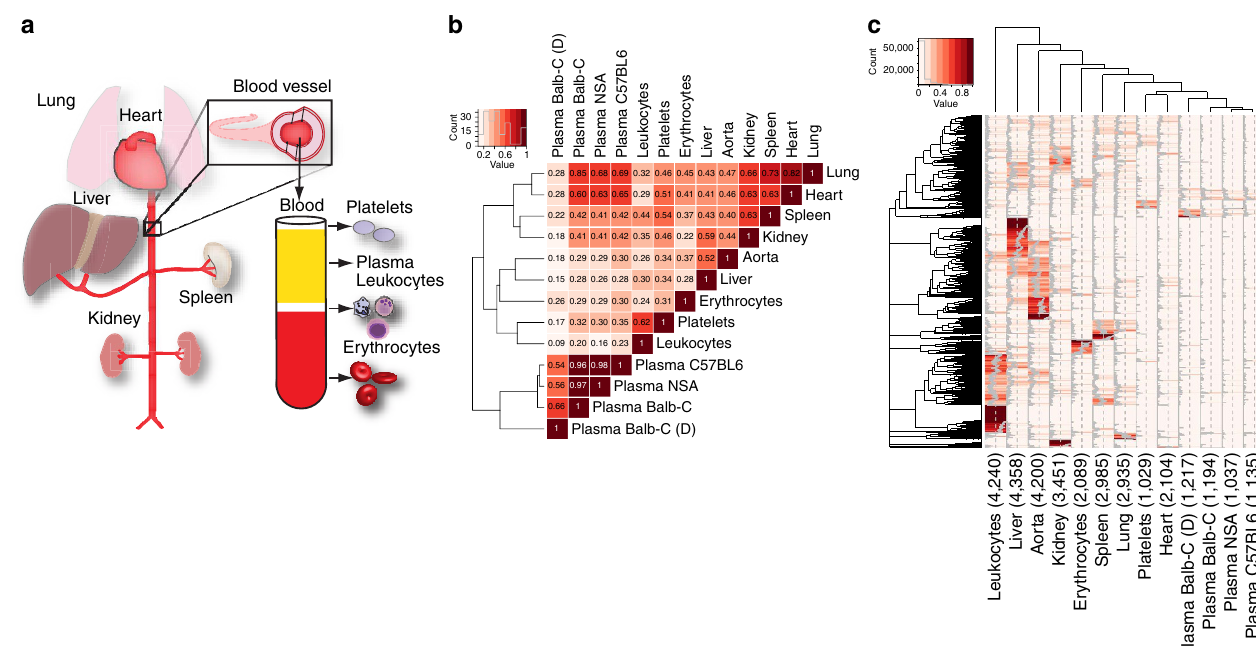
Figure 1 | Construction of a tissue-specific protein abundance atlas. ( a ) Vascularized organs, plasma and cells adjacent to the blood plasma were collected from healthy Balb-C mice. The collected organs and cells were washed in PBS, homogenized, the proteins digested with trypsin and analysed by shotgun LC-MS/MS. ( b ) The scaled spectral counts from the LC-MS/MS analysis of the individual organs and cells were correlated using Pearson’s r correlation coefficient, indicated by the numbers in the heat map. ( c ) Heat map of the scaled spectral counts of the different cell and organs. The grey lines in the heat map shows percentage of signal associated with a given organ or cell type. Total number of identified proteins per organ, blood vessel and cells is shown in brackets below the heat